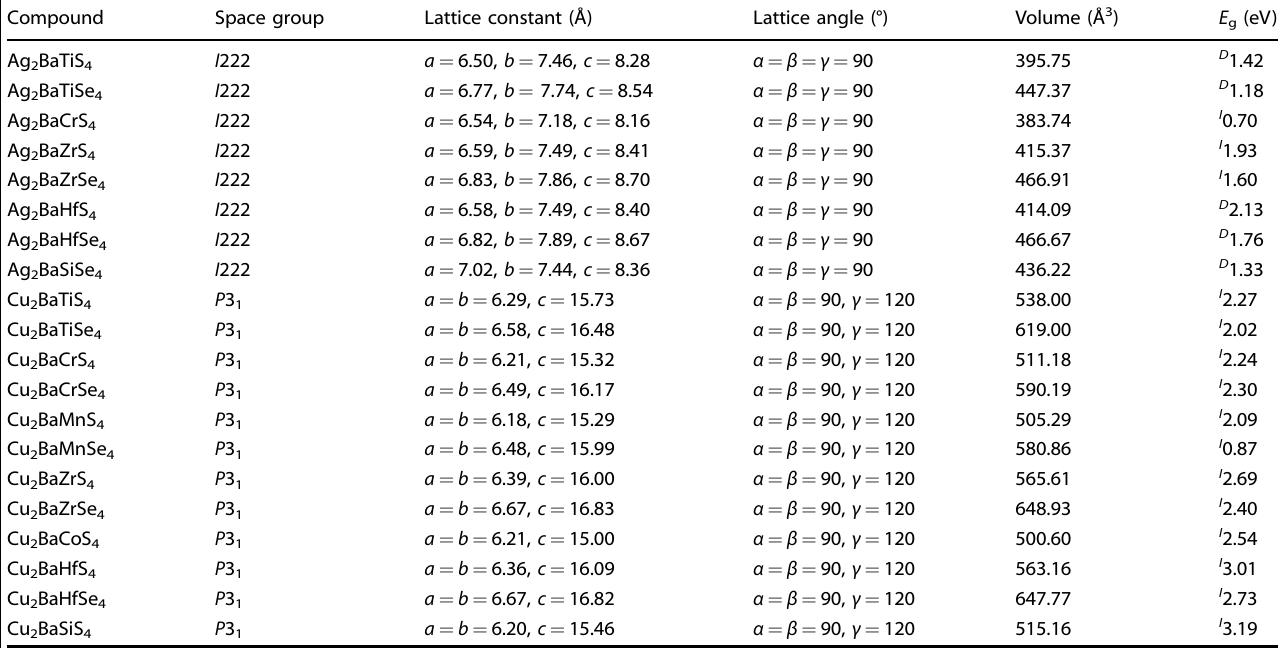
Table 1. Ab initio calculations for 20 semiconductors from G 3